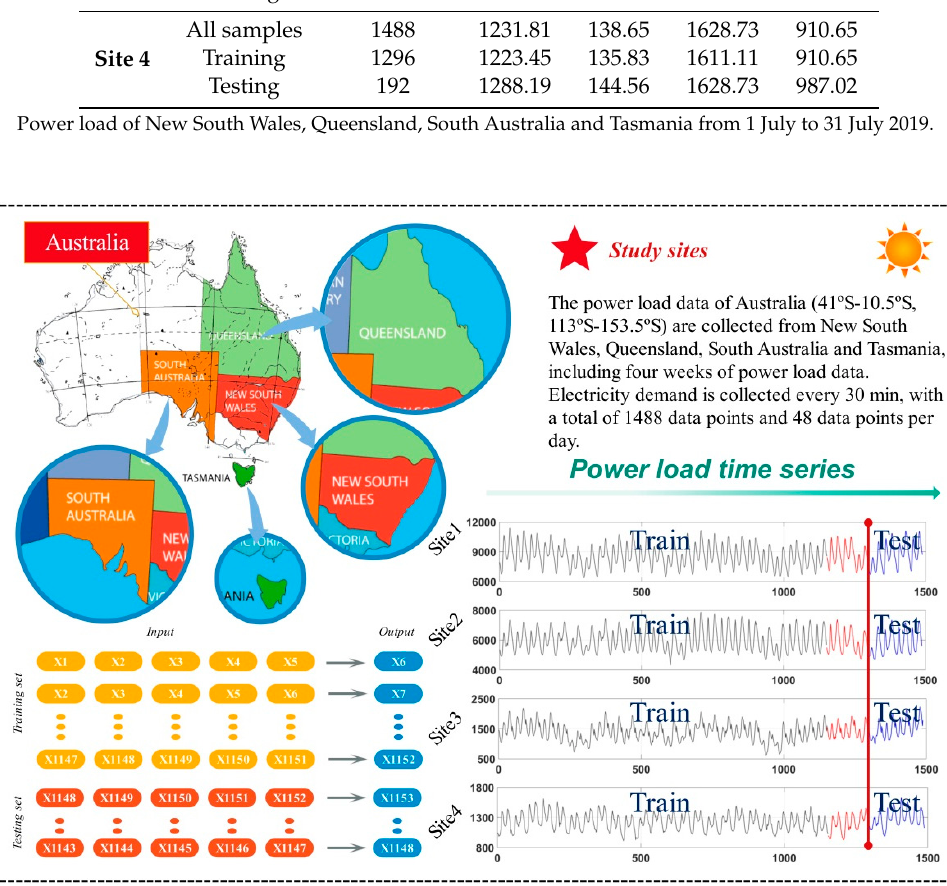
Figure 3. Description of observations in four sites. On the upper part is the geographic location obtained by data points. The lower part of the graph shows the divide method of training set and testing set.